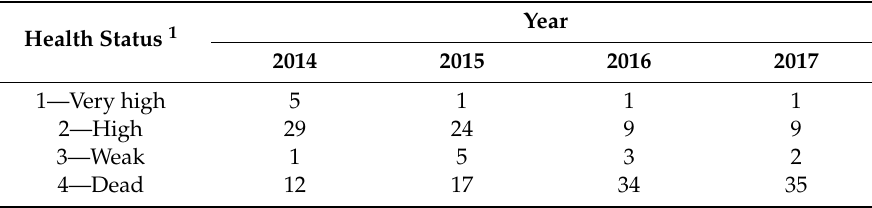
1 Classification of tree health status, detailed in Table 1.